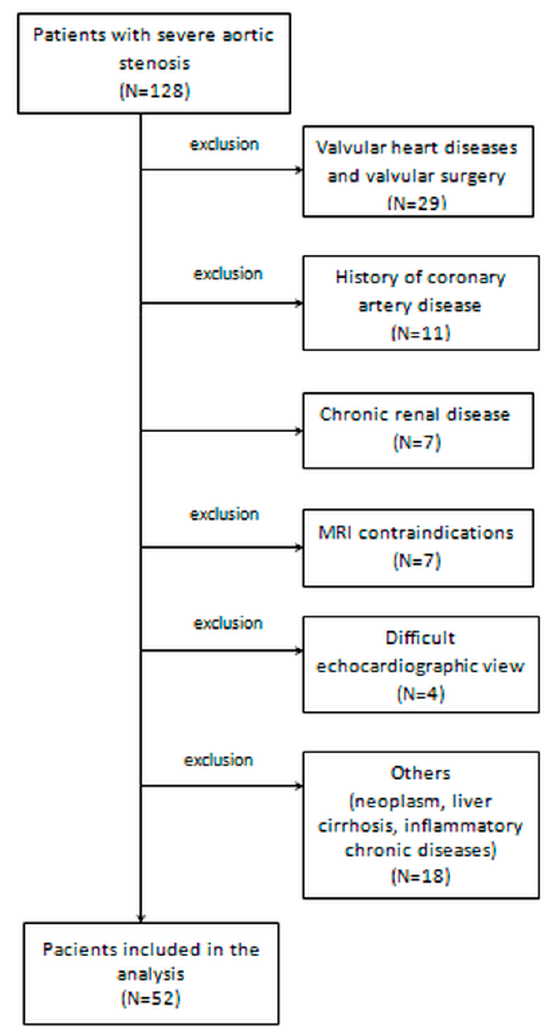
Figure 1. Patient selection and study design.